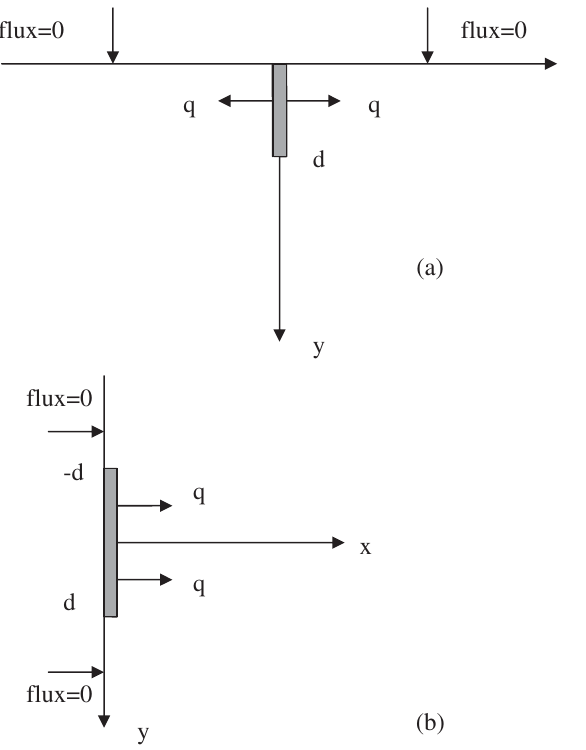
FIG. 4. Part (a) is the diagram of a crack of depth d on an infinite metallic plane, with zero flux on the plane surface ( y ¼ 0 ), and a flux q injected into both side walls of the crack ( j y j < d ). Part (b) is the diagram of a heat source of width 2 d placed symmetrically with respect to x axis on the surface of a half plane x > 0 , with zero flux at x ¼ 0 for j y j > d and flux q injected at x ¼ 0 , j y j < d